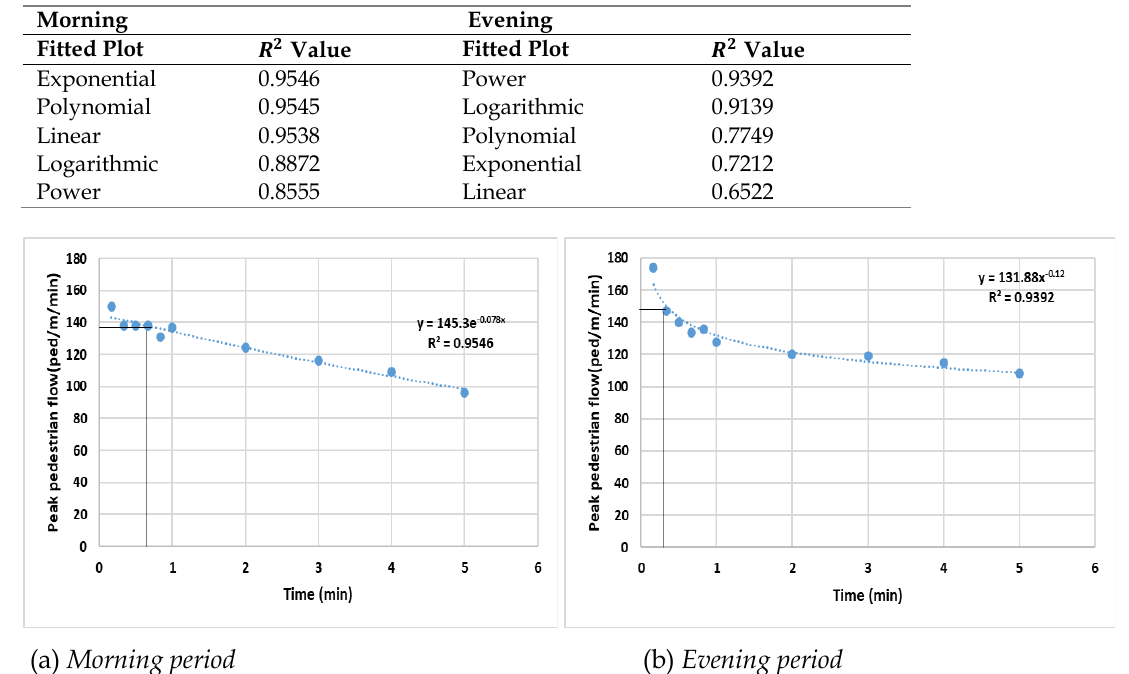
Figure 4. Cumulative Plot of Peak Flow Frequencies and 98 th Percentile Value Table 5. Curve Fitting Between Extraction Time and Peak Pedestrian Flow